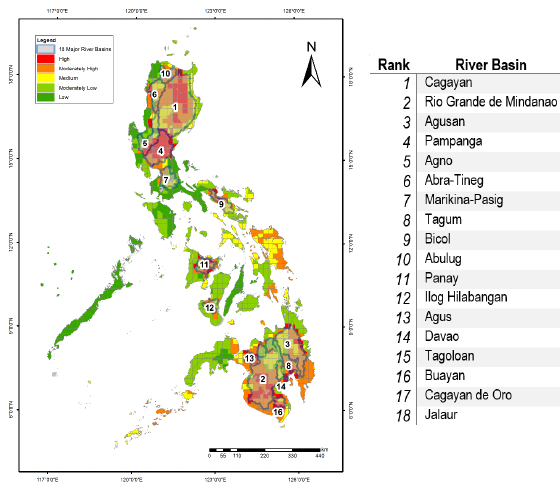
Figure 3. Flood vulnerability map for the Philippines with the locations of the 18 major RBs. Not labelled on the map are Cagayan de Oro Basin (#17) located in between Agus and Agusan basins and Jalaur Basin (#18) below the Panay Basin.